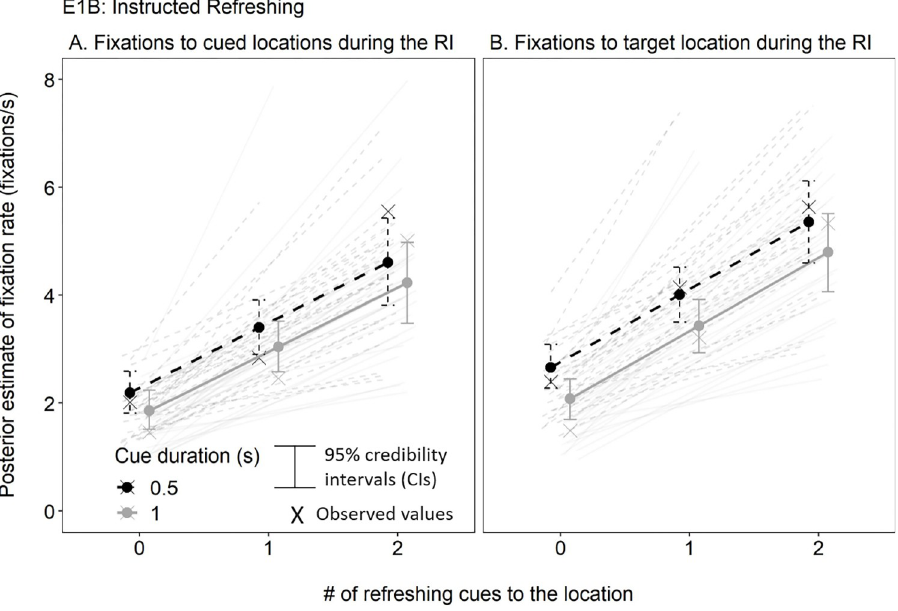
Fig 4. Research Question 1: Is Looking at Nothing Sensitive to Instructions to Refresh the Memoranda in Experiment 1B? Fixations to the Memoranda Decreased as the Presented Cues to those Locations Within the RI Increased (Panel A). However, Fixations to the Eventually Tested Target (i.e., the Predictor for Research Question 3), Increased as Cues to its Location Increased (Panel B). The Dark Lines Represent the Posterior Means and the Lighter Individual Lines Represent Individual Participant Means. The Xs Represent the Mean of the Observed